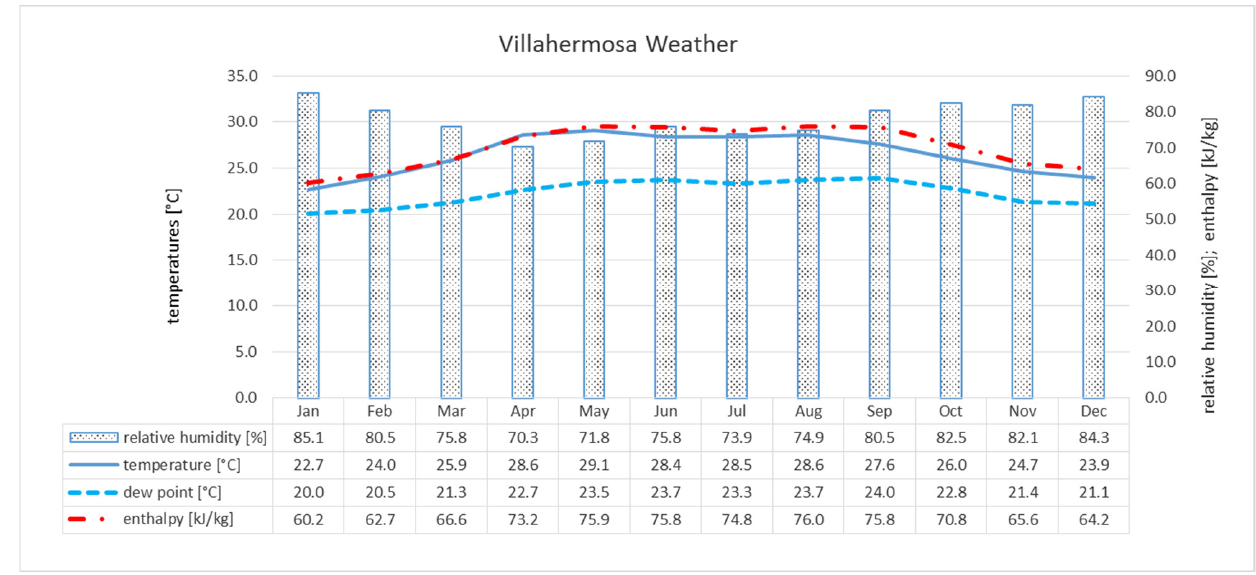
Figure 4. Villahermosa main weather parameter behaviour during the year.